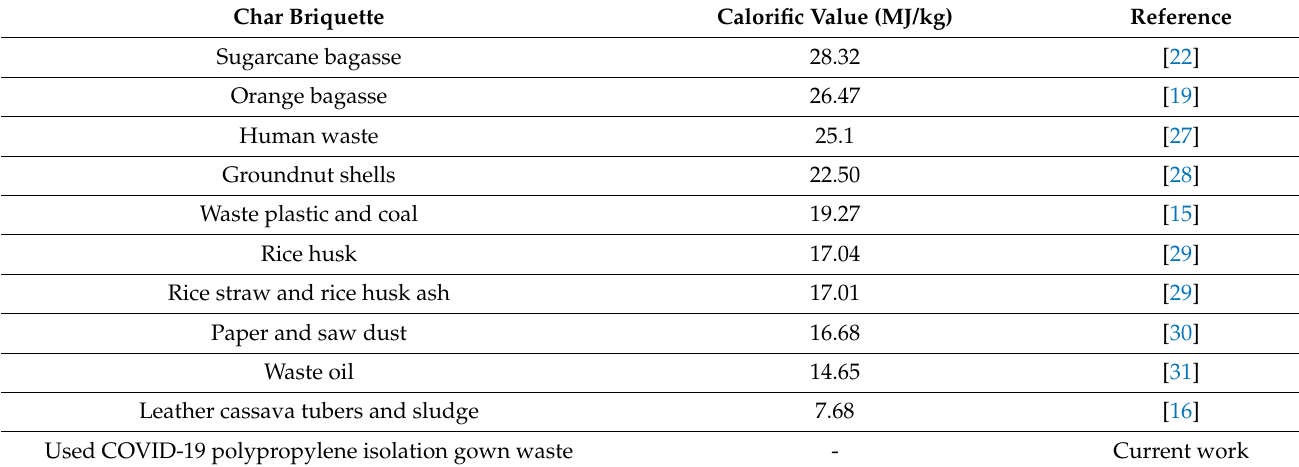
Table 1. Calorific values of other waste-derived